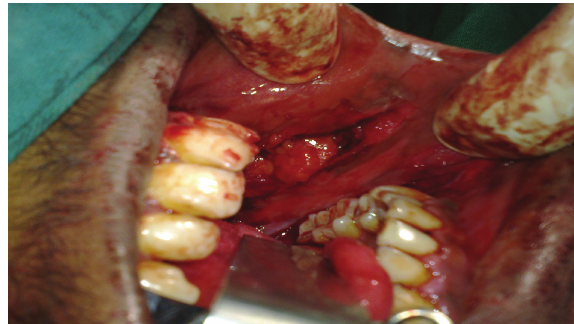
Figure 3: Incision and buccal fat pad exposed and